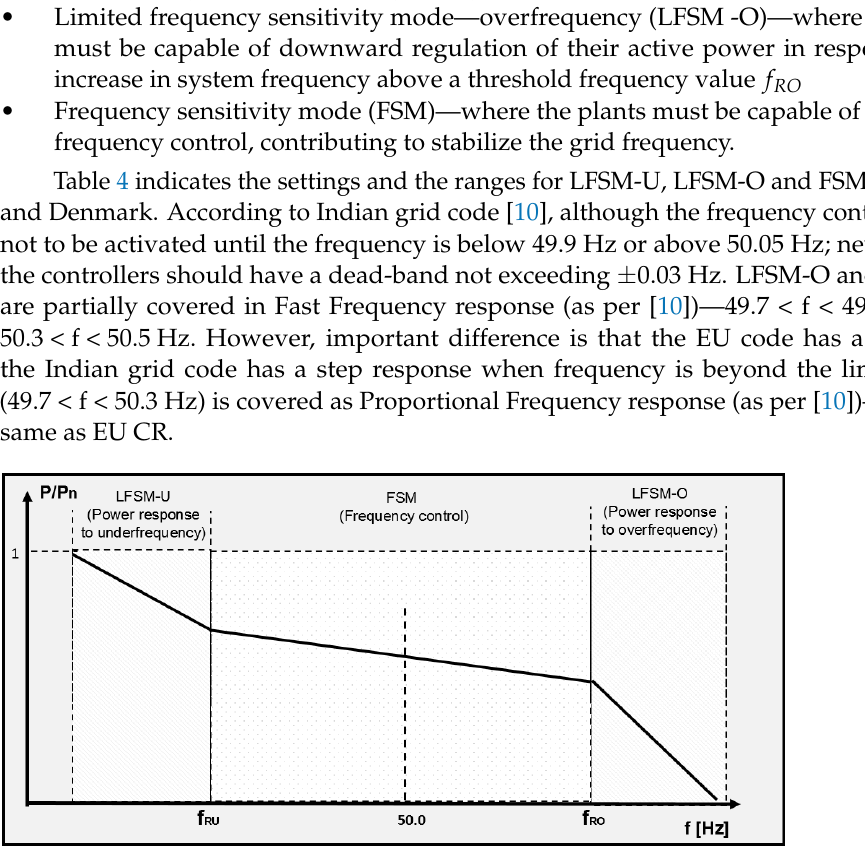
Figure 3. Frequency control and frequency response EU CR. Reprinted from